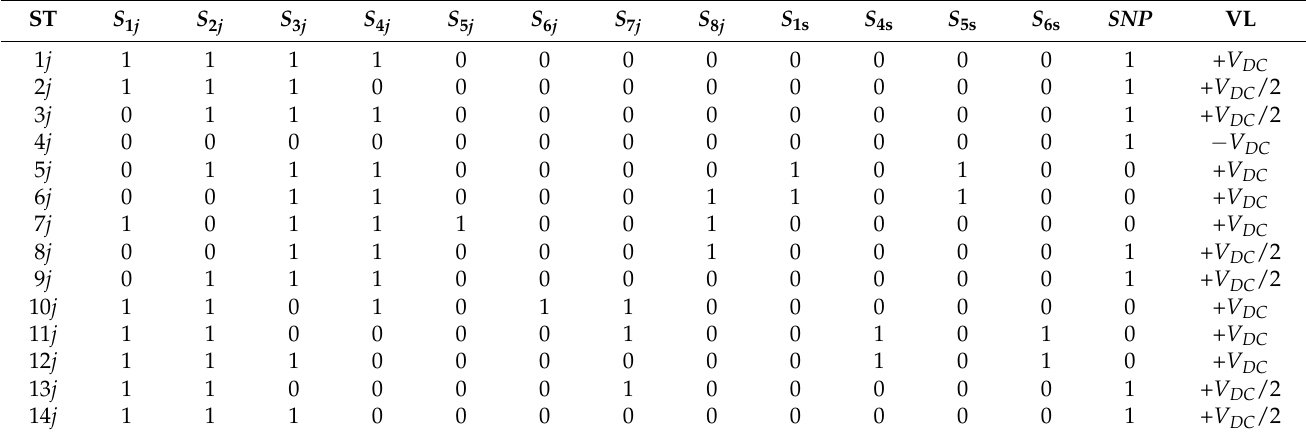
Table 2. Summary of possible switching states in normal and faulty operation for each generic j